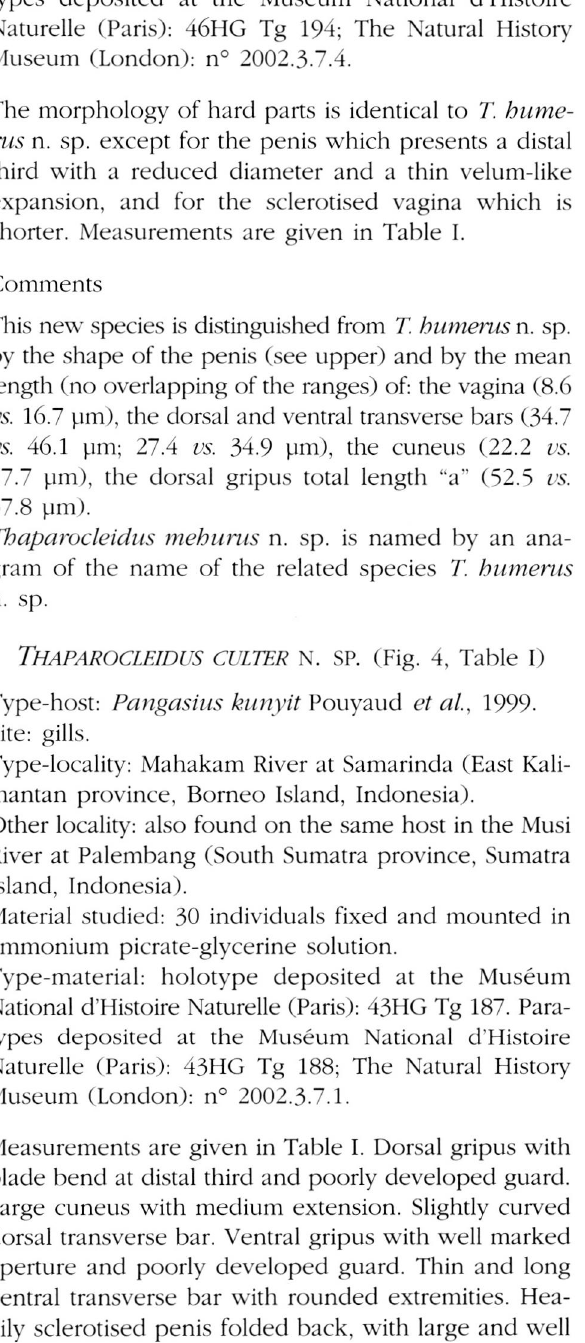
Fig. 3. - Tbaparocleidus mehurus n. sp. C = cuneus; DB = dorsal transverse bar; DG = dorsal gripus; MA = male apparatus; VB = ventral transverse bar; VG - ventral gripus; Vg = vagina; L" = uncinuli. Bar = 30